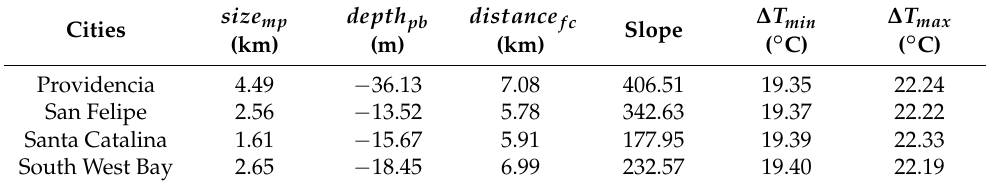
Table 3. Break of the continental platform at four points of Providencia and Santa Catalina. size mp depth pb distance fc Cities